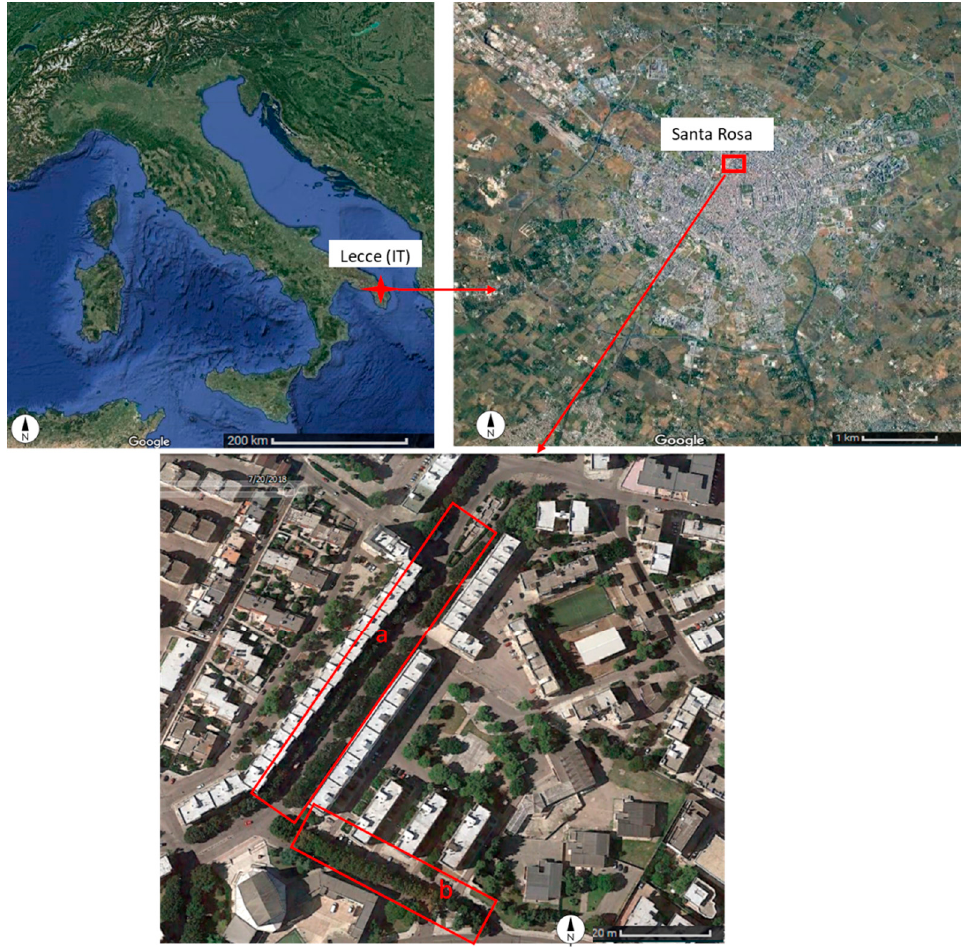
Figure 1. Top: position of the city of Lecce in southern Italy with a focus on the study area (referred to as Santa Rosa hereinafter). Bottom: three-dimensional (3D) view of Santa Rosa with indication of two street canyons (‘a” and “b”) on which the analysis is focused (modified from Google Earth); see Section 3 for more details.